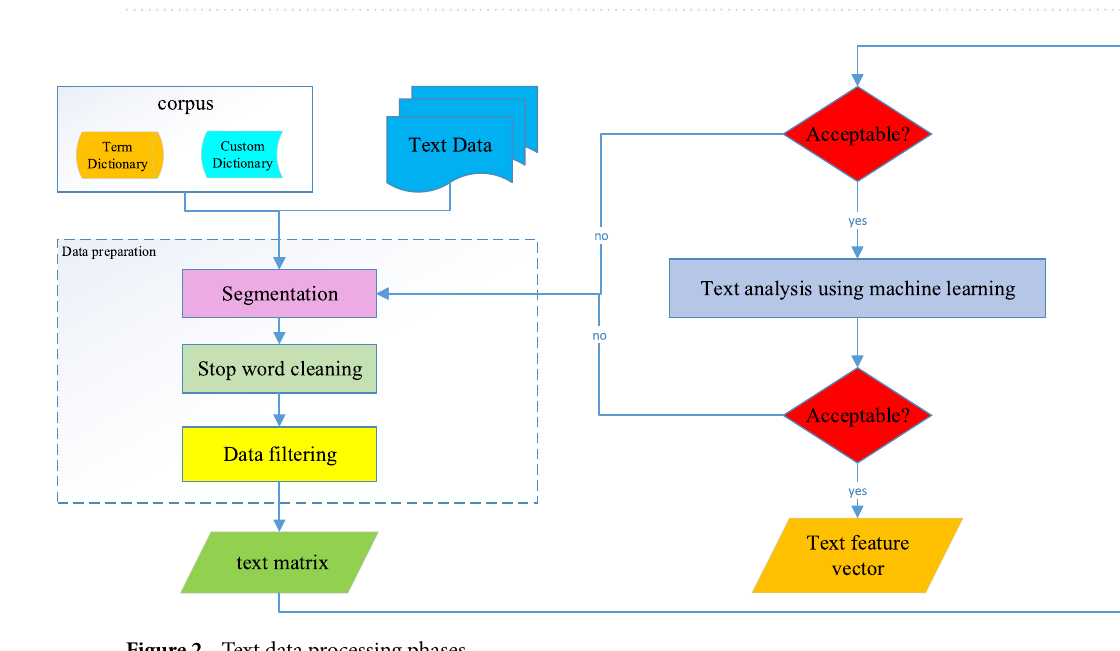
Figure 2. Text data processing